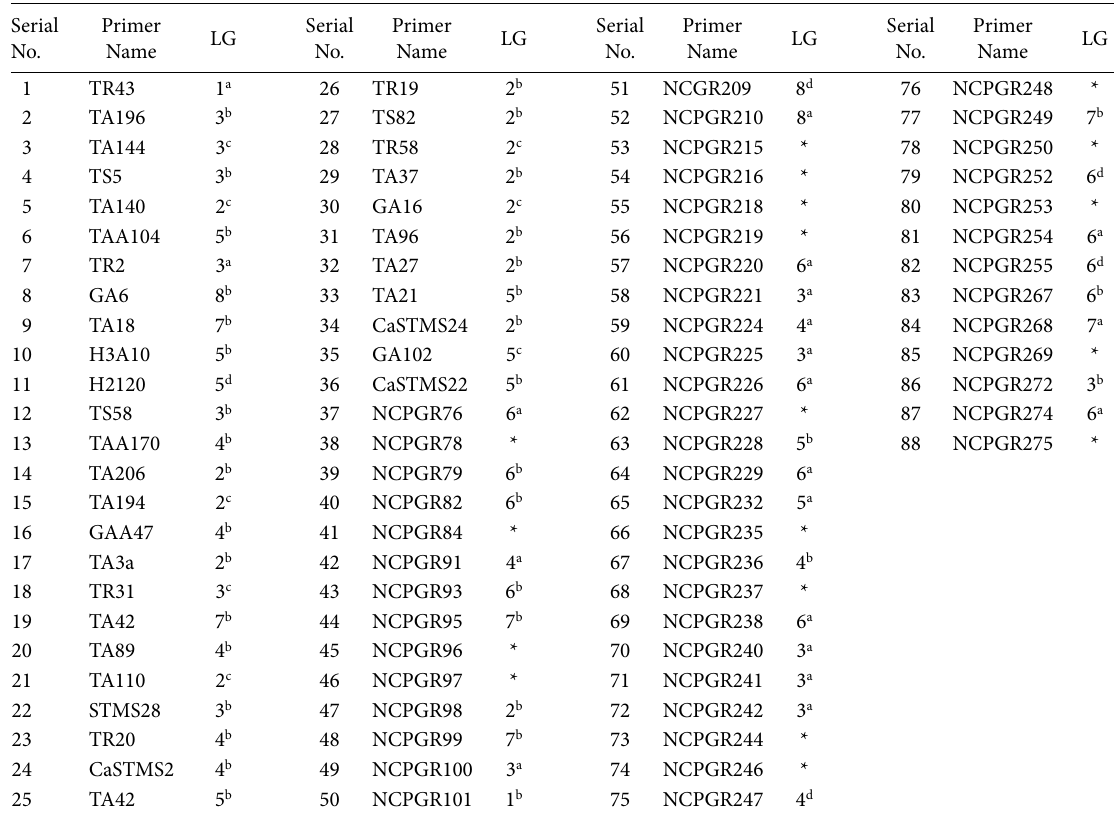
Table 3 List of polymorphic SSR markers used for bulked BSA in the five most Botrytis grey mould resistant and five most susceptible lines, and their corresponding bulks with their linkage groups